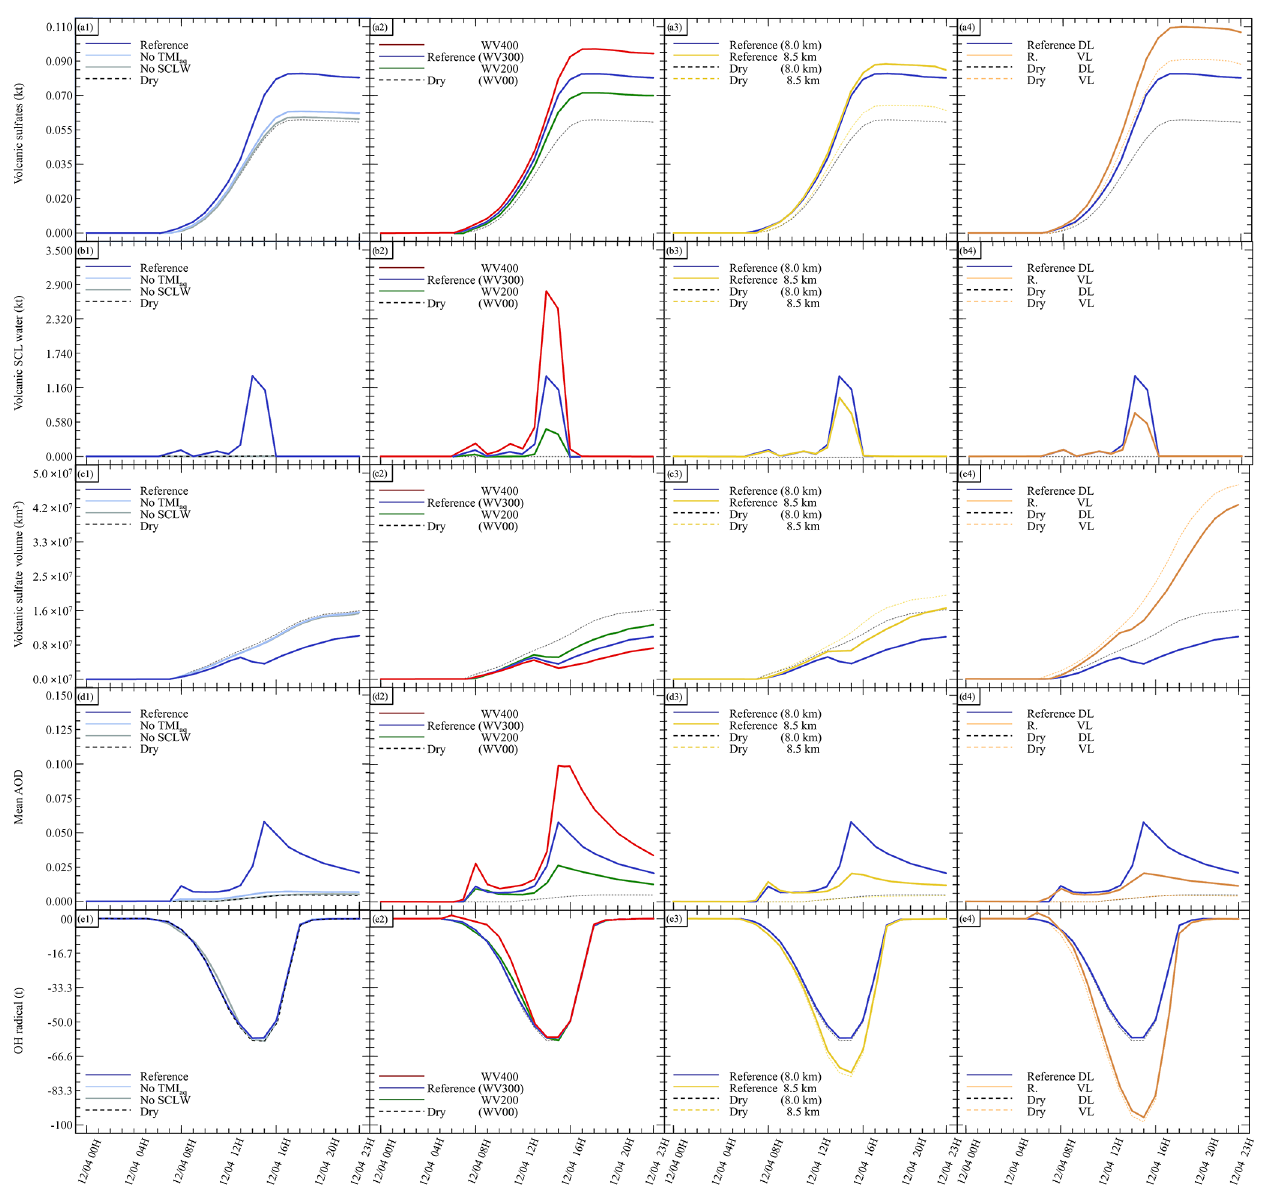
− (kt), (b) supercooled liquid water (kt), (c) the minimum 4(p) mass and (e) the OH radical (t). The Reference simulation 4(p)